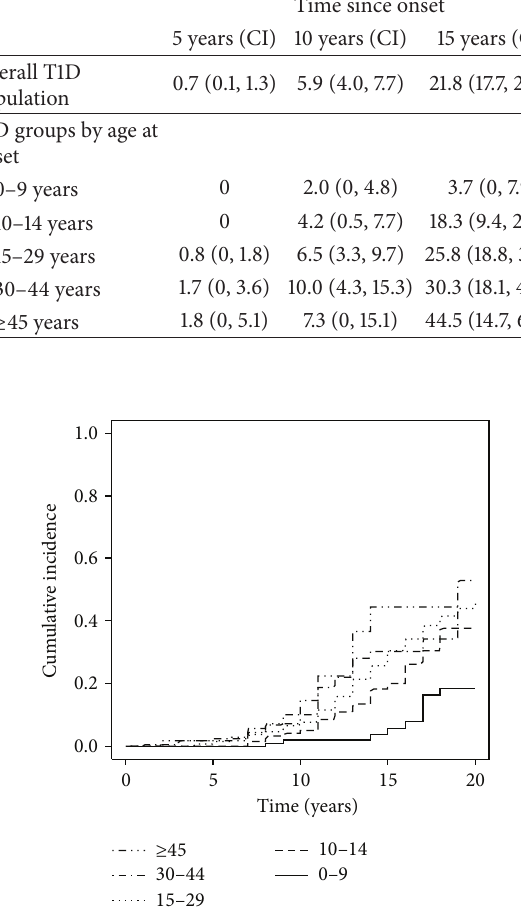
Figure 1: Cumulative incidence of retinopathy by age